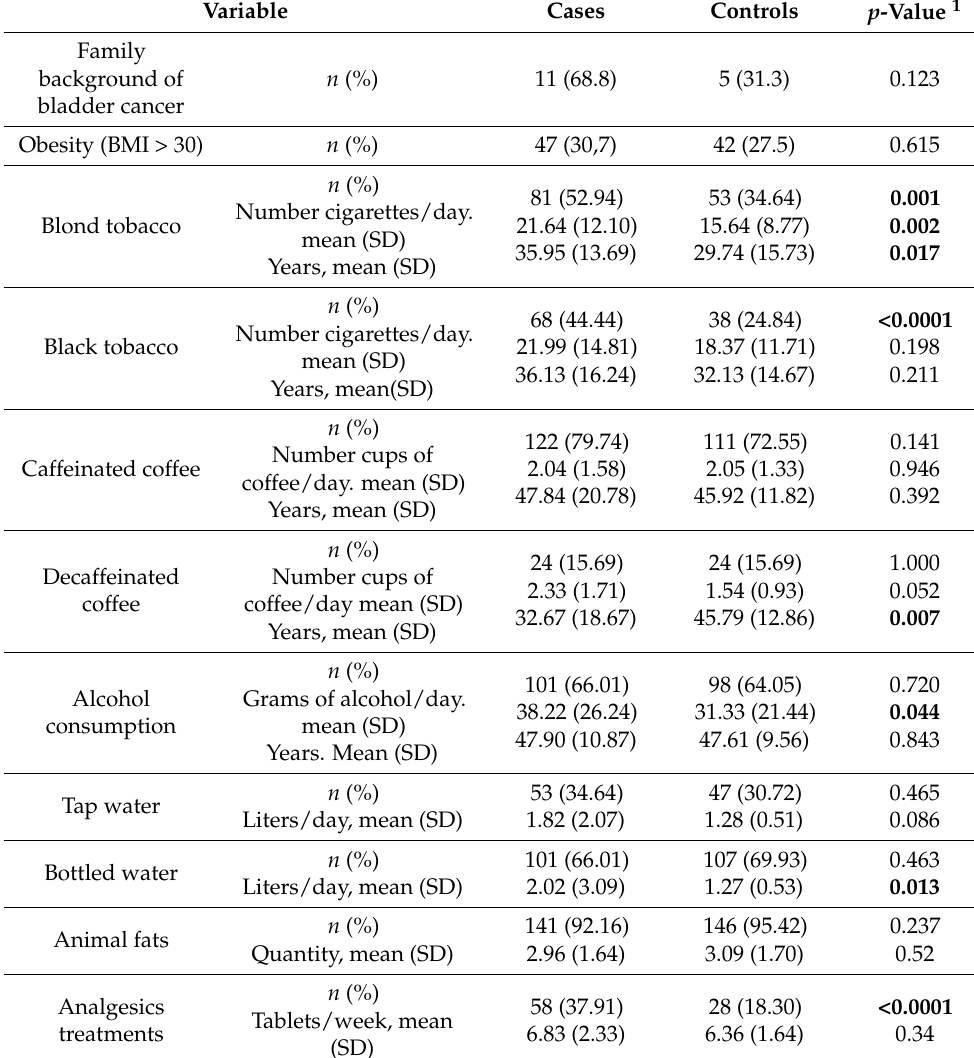
Table 1. Bivariate assessment of risk factors involved in bladder cancer in West Vall è s